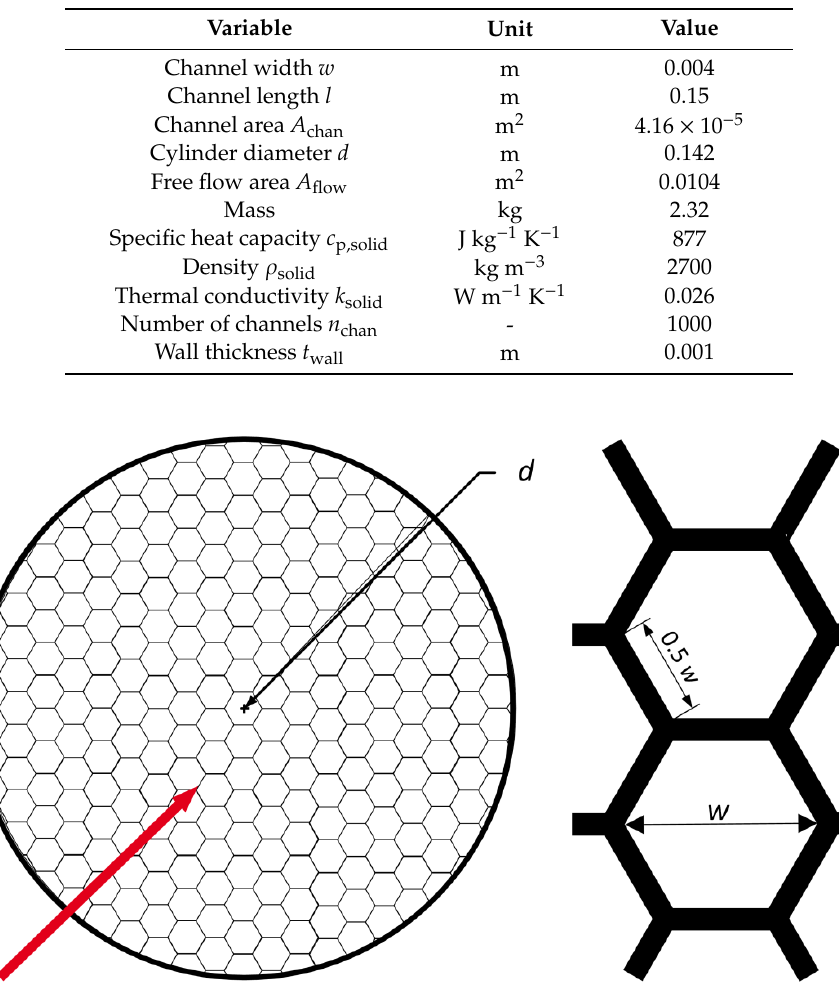
Figure 2. Scheme of the honeycomb ceramic regenerator; front view ( left ) and channel model ( right ). Table 2. List of parametric values. The used characteristic length to calculate the Reynolds number is the hydraulic diameter d h , defined in Equation